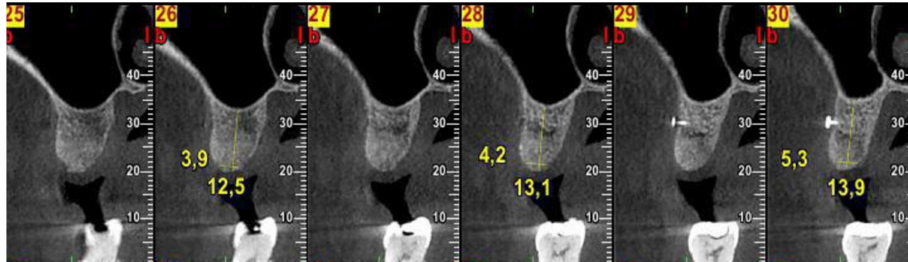
Figure 9. The CBCT taken at 6 months post op shows perfect integration of the graft and lamina and 7 mm of measurable vertical ridge augmentation.